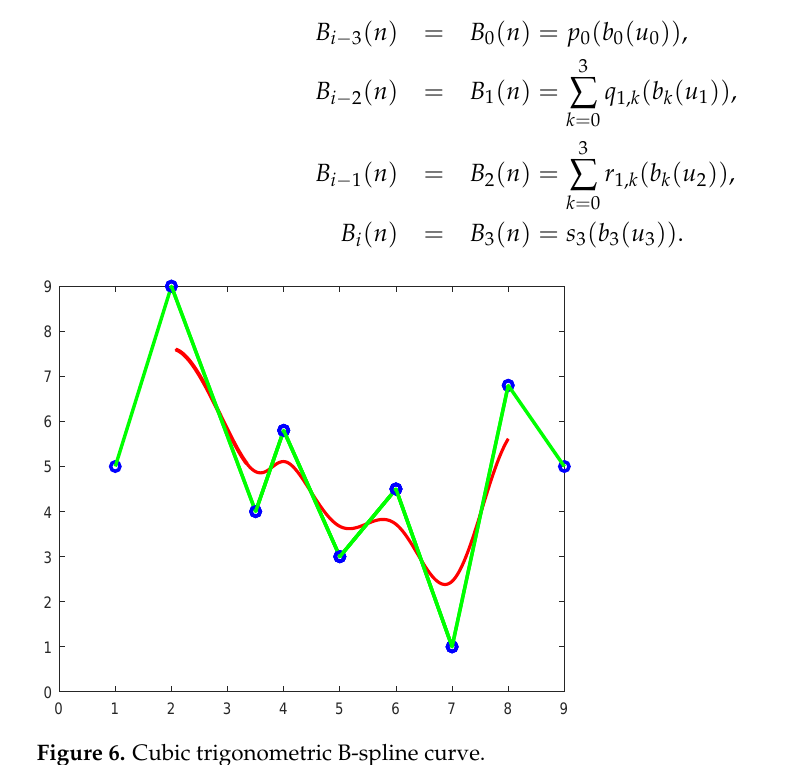
Figure 6. Cubic trigonometric B-spline curve.